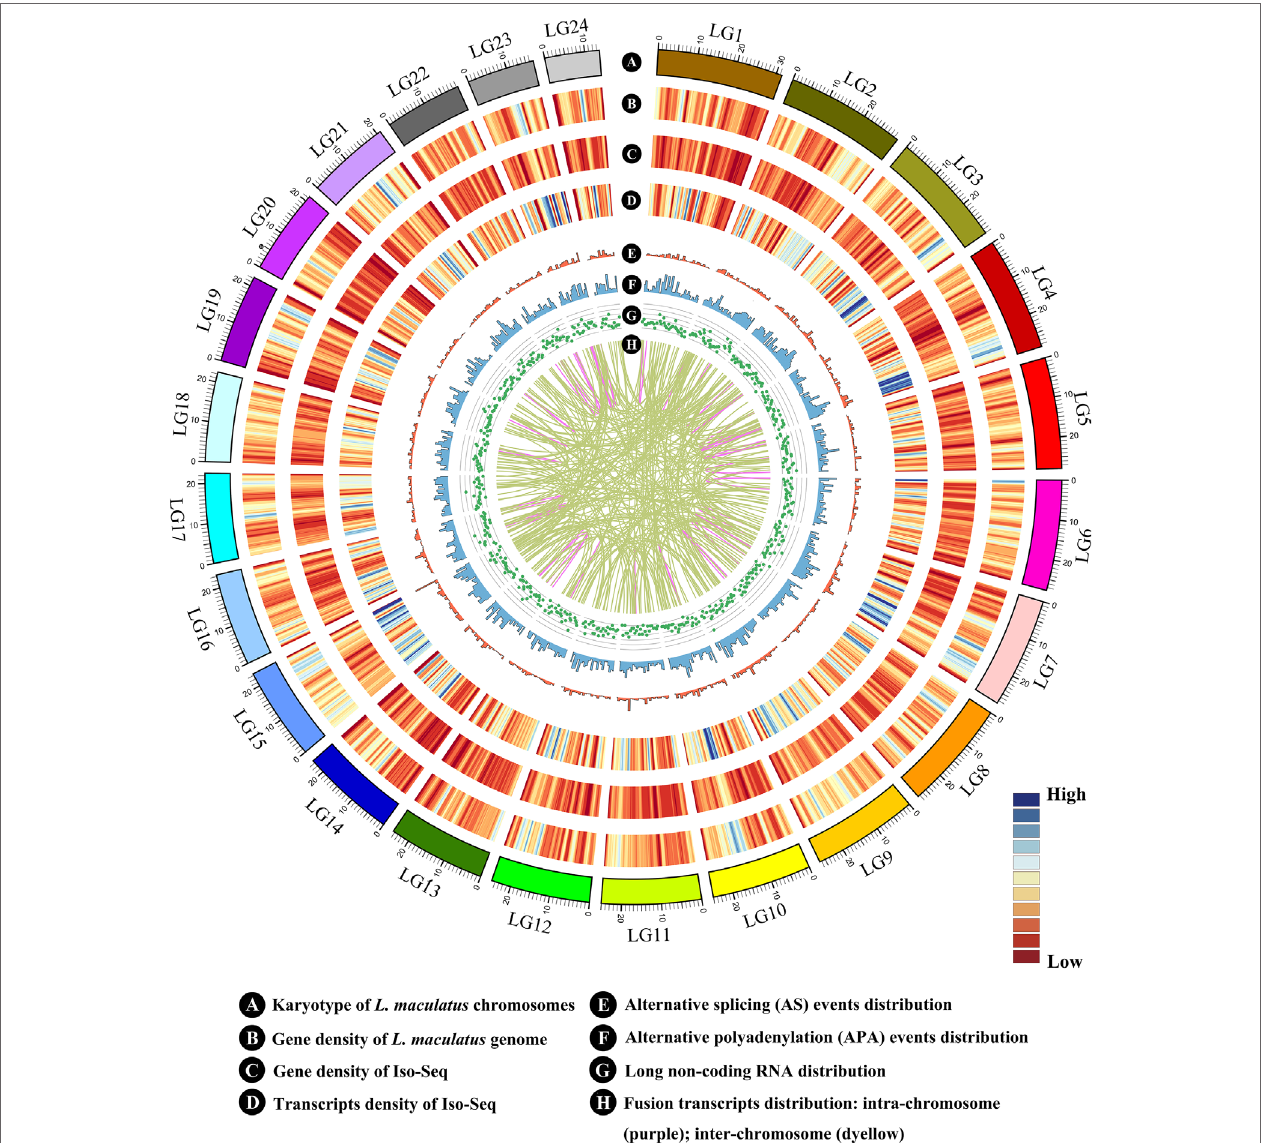
FIgURe 2 | Circos visualization of L. maculatus genome and Iso-Seq results. (a) Karyotype of the L. maculatus chromosome; (B) Gene density of the L. maculatus genome; (C) Gene density of Iso-Seq; (D) Transcript density of Iso-Seq; (e) Alternative splicing (AS) events distribution; (F) Alternative polyadenylation (APA) events distribution; (g) Long non-coding RNA distribution; and (h) Fusion transcripts distribution: intra-chromosome (purple); inter-chromosome (deyellow). The distribution was calculated in a 1-Mb sliding window at 20 kb